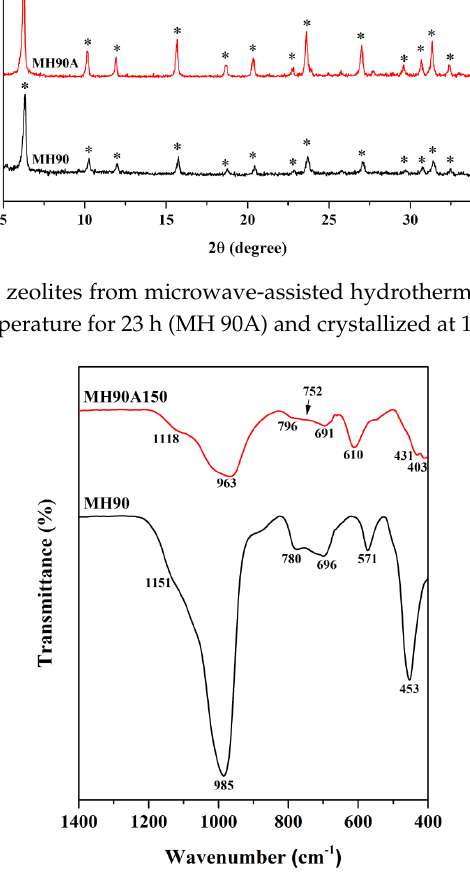
Figure 6. Fourier-transform infrared spectroscopy (FTIR)–attenuated total reflectance (ATR) spectra of zeolite products: MH90 from the microwave-assisted hydrothermal method at 90 °C for 1 h and MH90A150 from the microwave-assisted hydrothermal method at 90 °C for 1 h followed by aging at room temperature for 23 h and recrystallization at 150 °C for 1 h.